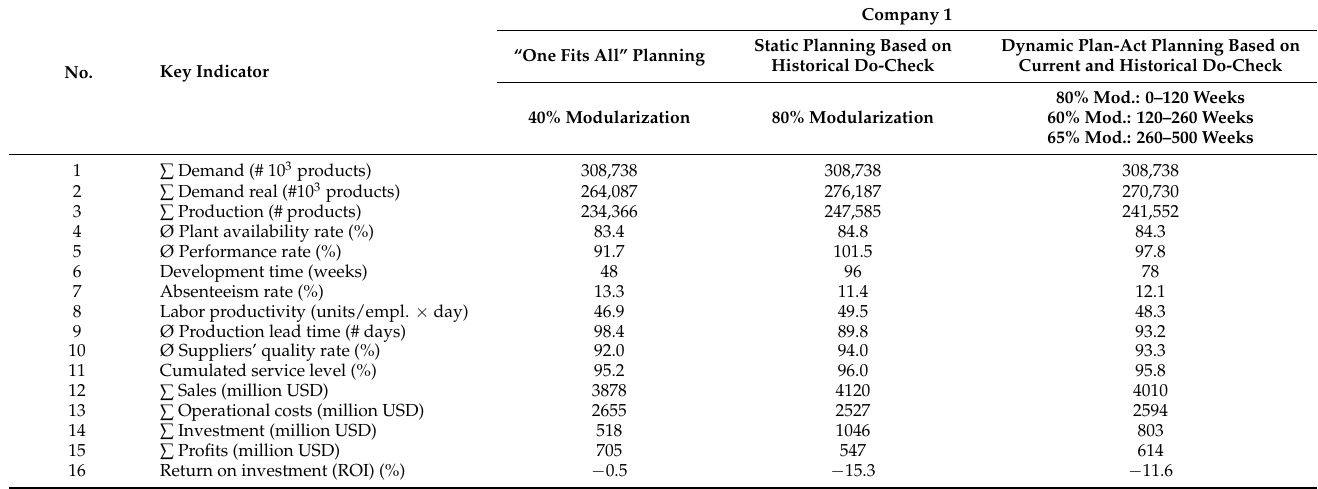
Table 1. Simulation results for the Innovation Case Study: Product Modularization in Company 1.